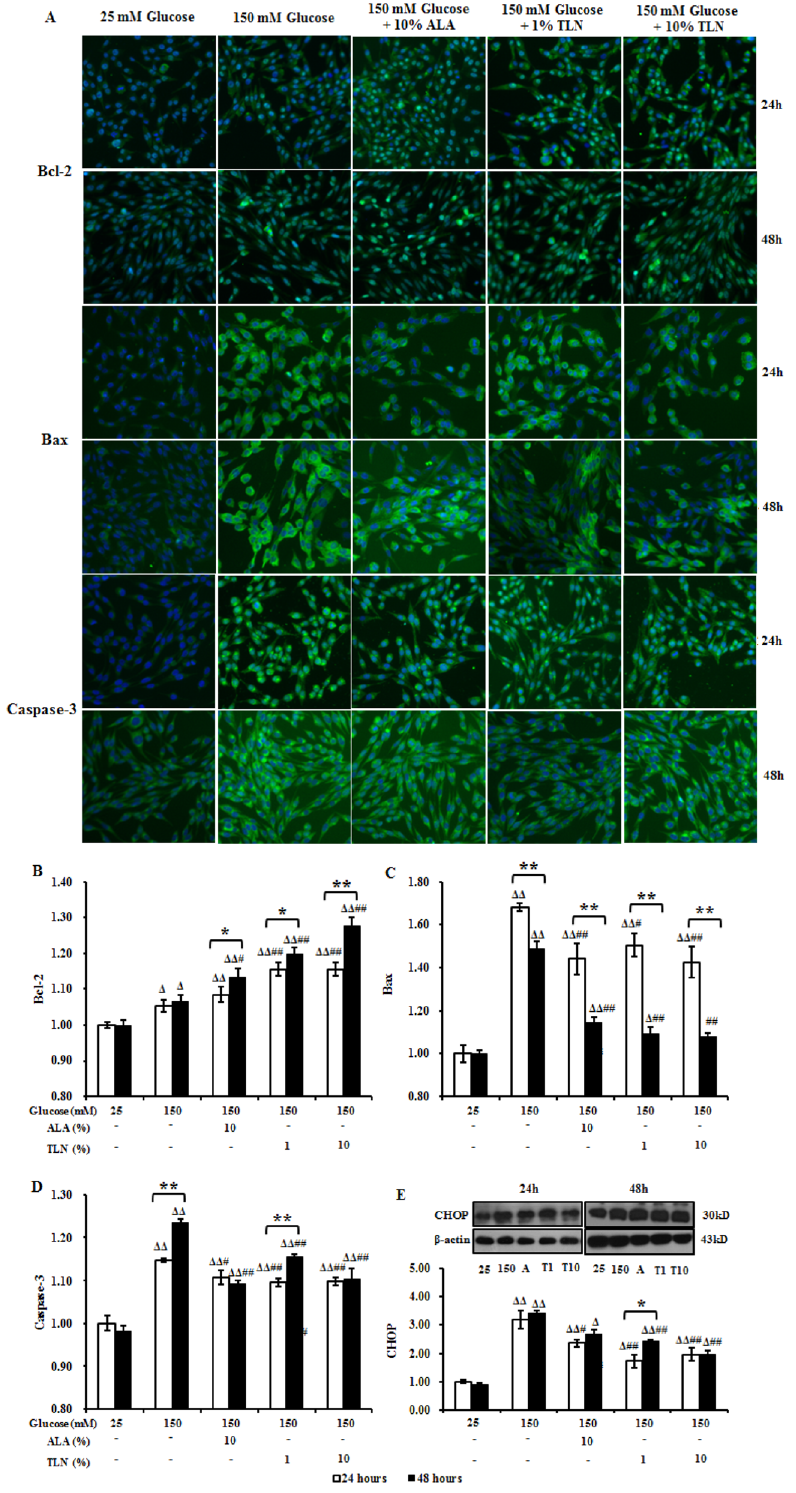
Figure 5. Effects of TLN on the expression of CHOP, Bcl-2, Bax and Caspase-3 in RSC96 Cells. ( A ) High content analysis of Bcl-2, Bax and Caspase-3 at 24 and 48 h. Images show immunostaining of RSC96 cells (10 × magnification). ( B – D) Fold changes of Bcl-2, Bax and Caspase-3 relative to these in 25 mM glucose-treated cells. ( E ) Western blots of CHOP in RSC96 cells at 24 and 48 h and fold changes relative to these in 25 mM glucose-treated cells. Data are represented as the means ± S.E.M. Δ P < 0.05, ΔΔ P < 0.01 vs. 25 mM glucose groups; # P < 0.05, ## P < 0.01 vs. 150 mM glucose groups; * P < 0.05, ** P < 0.01 vs. treated after 24 hours. Data were analyzed by One-way ANOVA followed by least significant difference or Tambane’s T2 analysis and Student’s unpaired t-test compared to 24 hours’ time point. (n = 4 per